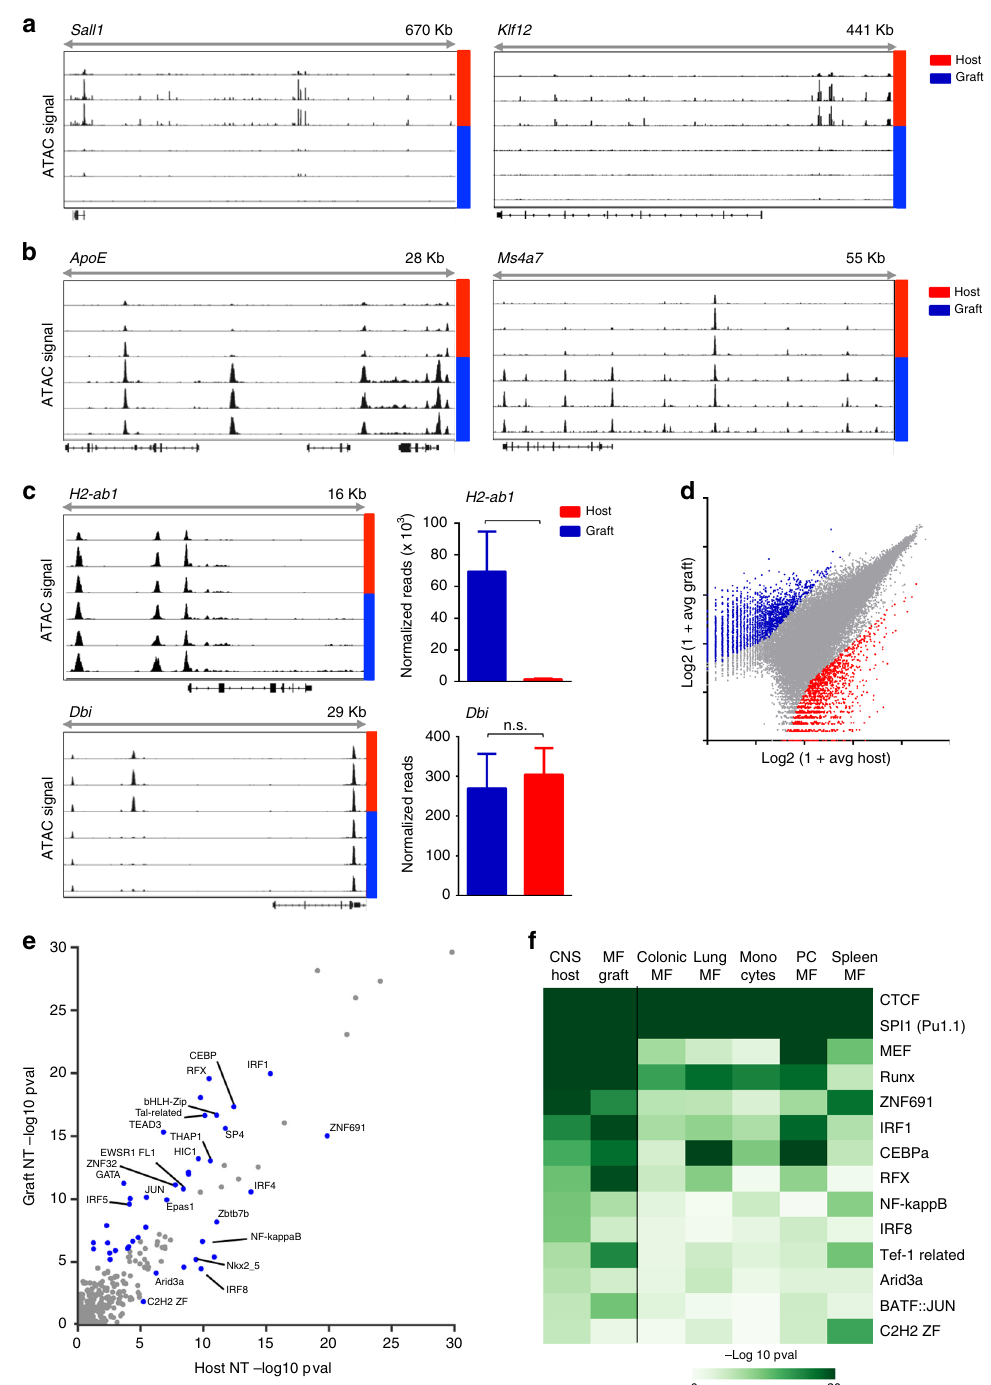
Fig. 4 Comparative epigenome analysis of grafted cells and host microglia. a IGV tracks of Sall1 and Klf2 loci showing ATAC signals in host (red) but not engrafted (blue) cells. N = 3. b IGV tracks of ApoE and Ms4a7 loci showing ATAC signals in engrafted cells (blue) but not host (red) microglia. N = 3. c ATAC-seq IGV tracks (left, n = 3) and normalized RNA seq reads (right, n = 4) of H2-ab1 and Dbi in host microglia (red) and engrafted cells (blue). + — p - value < 10 − 5 , n.s. — p -value > 0.05. d Analysis of all 58,947 detected ATAC peaks, from which 1506 peaks and 2,176 peaks displayed >4-fold signi fi cant ( p - value < 0.01) enrichment in host microglia and engrafted cells, respectively. Source data are provided as a Source Data fi le. e Comparison of motif signi fi cance in resting host and grafted cells. P -values were calculated using TBA models trained on intergenic peaks from host and grafted cells. Signi fi cant motifs that show a large difference ( p < 10e − 5, log-likelihood ratio > = 2) are indicated in blue points. Source data are provided as a Source Data fi le. f Heatmap of the signi fi cance of motifs in various myeloid cell types and host cells. The intensity of the color indicates greater signi fi cance ( − log10 p -value) of each motif. Source data are provided as a Source Data fi